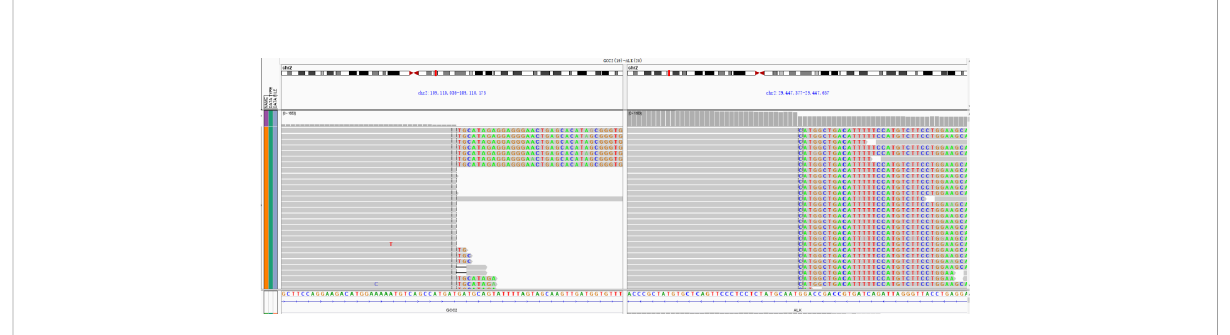
FIGURE 3 GCC2-ALK fusion was identi fi ed by next-generation